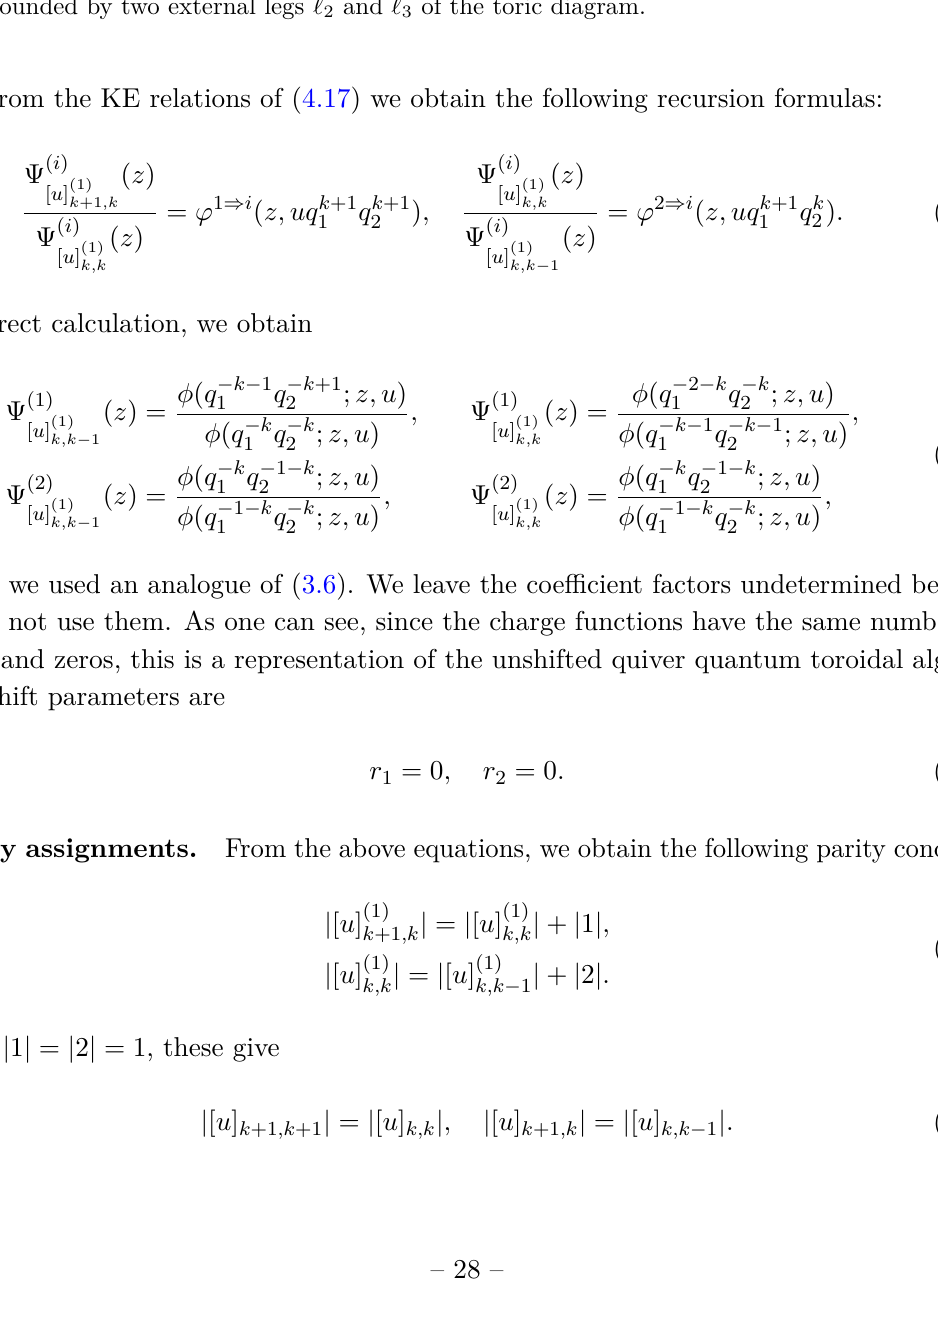
= { α from the 2 2 } = q − 1 . The labels ‘ and ‘ come from the fact that the divisor 2 2 3 1 and ‘ of the toric 2 3